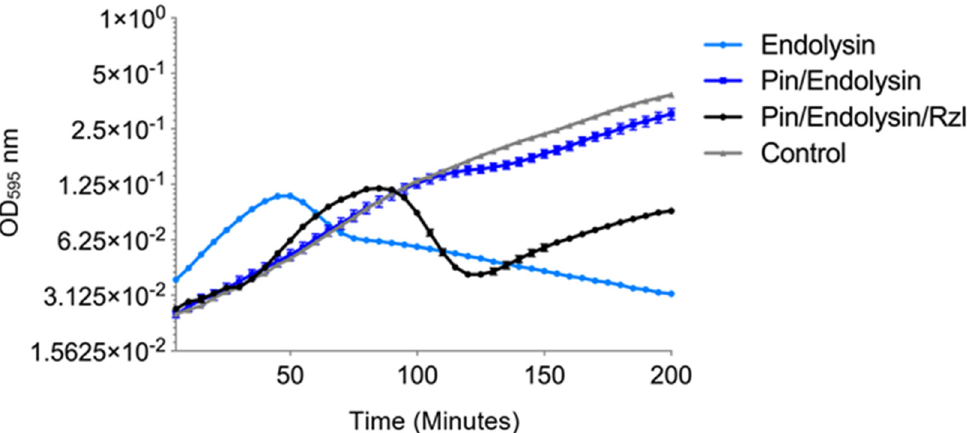
Figure 5. E ff ect of expression of individual lysis protein constructs containing either the φ NV3 endolysin, pinholin, or Rz / Rz1-like encoding genes on optical density of BL21-AI E. coli following induction with 0.2% L-arabinose at T = 0. The control comprised of an uninduced BL21-AI containing the Rzl / Rz1-like construct. Mean values of 6 replicates are plotted, error bars = +/ − SEM.